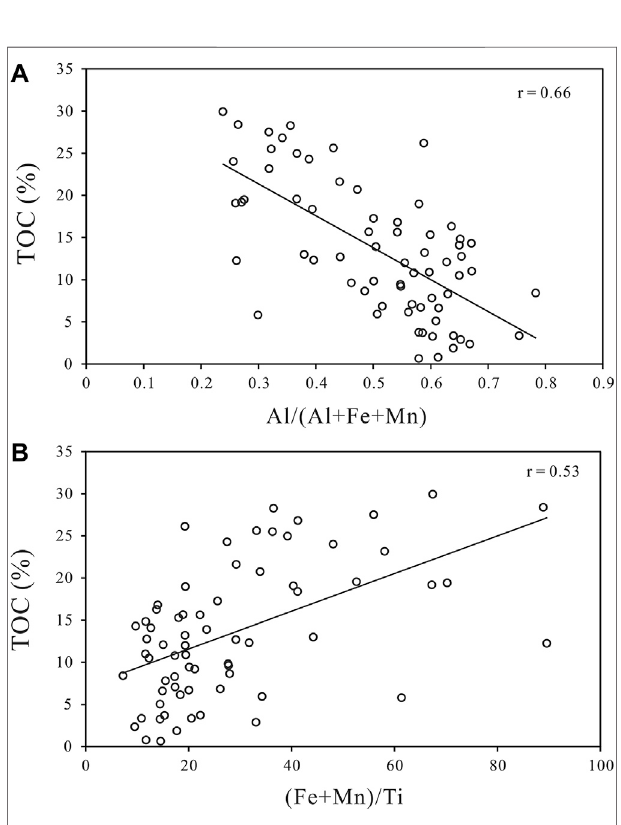
FIGURE11| RelationshipofTOCcontentswithAl/(Al+Fe+Mn)and(Fe + Mn)/Ti in the Chang 7 black shale of the Ordos Basin.